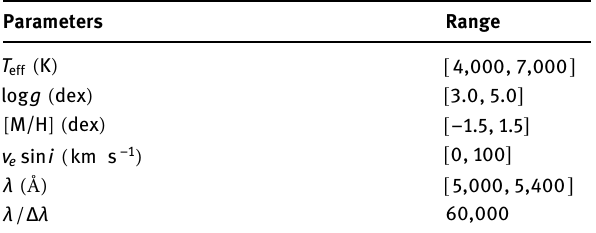
Table 4: Ranges of the parameters used for the calculation of the FGK synthetic spectra TDB